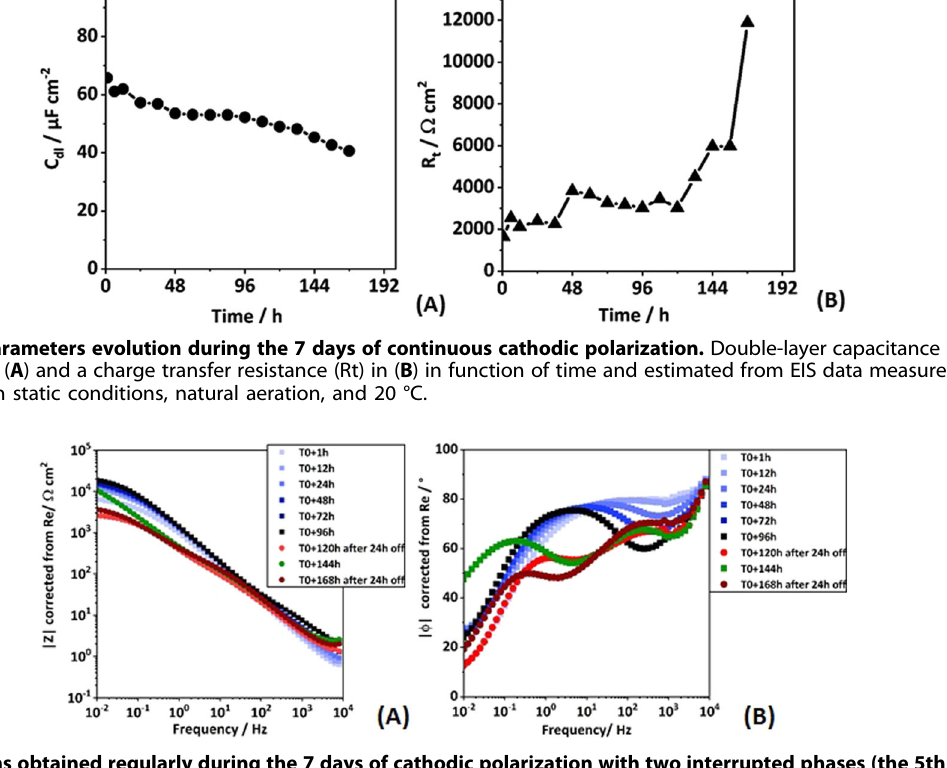
Fig. 12 Bode diagrams obtained regularly during the 7 days of cathodic polarization with two interrupted phases (the 5th and 7th days). The modulus in ( A ) and phase in ( B ) are plotted in function of the frequency and corrected from the “ Re ” (Electrolyte Résistance), for unpainted DH36 steel immersed in naturally aerated arti fi cial seawater and in static conditions at 20